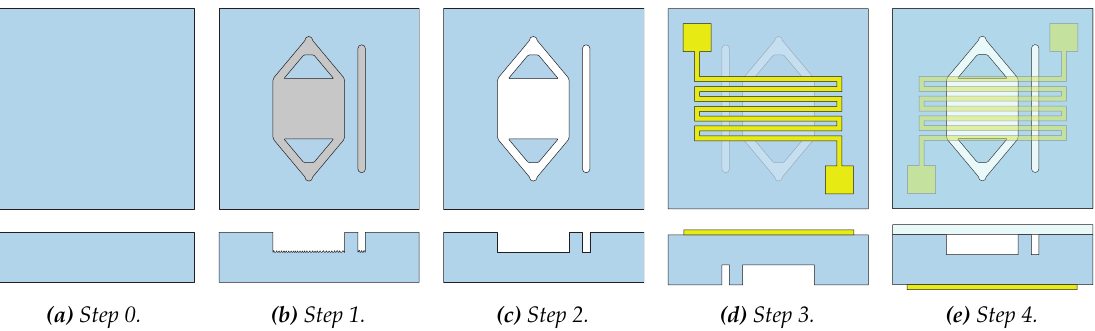
Figure 4. Schematic top views (top row) and cross-sectional representations (bottom row) of the full fabrication process. In panel ( a ) the pristine COC substrate is shown as step 0. Then, in panel ( b ) the first step is shown, i.e., the milling of the reaction chamber and temperature monitor chamber. In panel ( c ), the cyclohexane vapor post-treatment is shown. Then, the substrate is flipped and metal